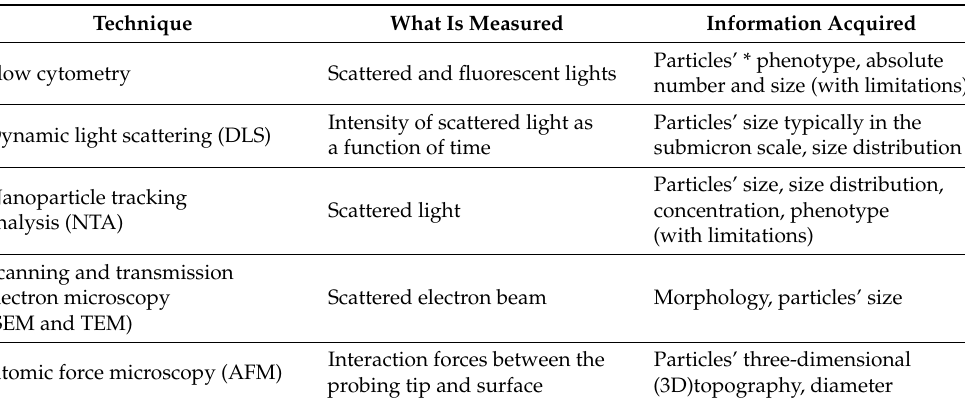
Table 1 enlists the most widely used techniques in EVs studies. Table 1. The most common techniques used in the studies of the